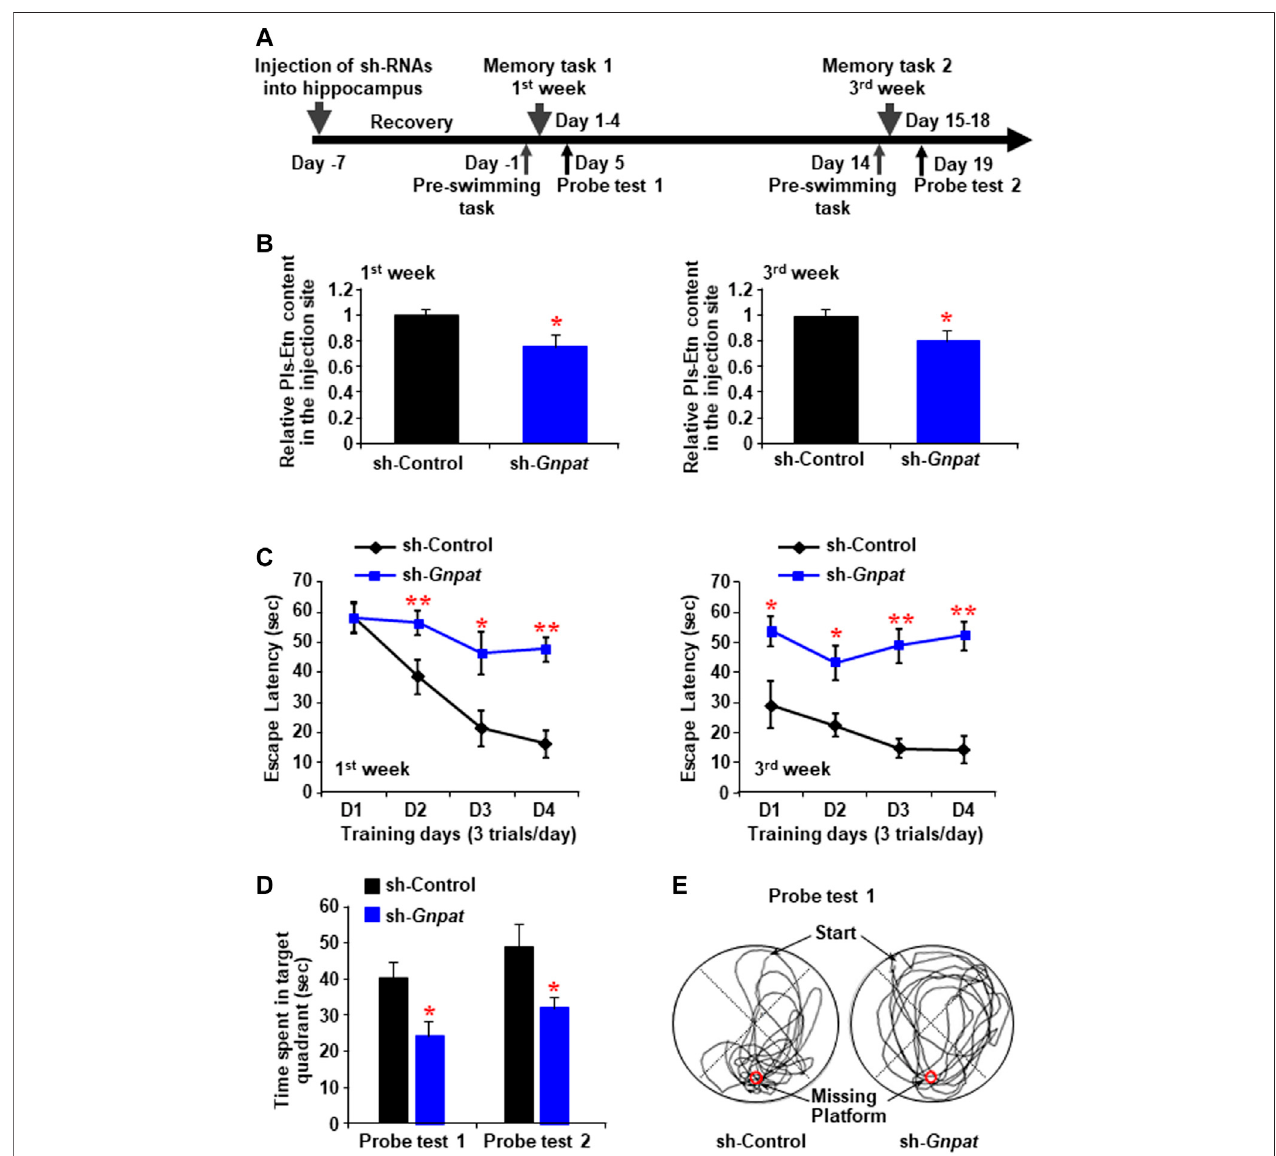
FIGURE 1 | Memory impairmentby the reduction of plasmalogen in the hippocampus. (A) Schematic diagram shows the memory tasks and probe trials schedule after the intrahippocampal injection of sh-RNA against Gnpat . (B) Mass spectroscopic data show the relative amount of ethanolamine Pls (Pls-Etn) in the hippocampus infected with lentiviruses (5 × 10 5 TDU). (C) Morris water maze task shows in the change in escape latency at the fi rst week (left panel) and third week (right panel). Data are the mean ± S.E.M. of three independent experiments. Each experiment included more than fi ve mice whose hippocampus was successfully infected by sh- GNPAT . (D) Probe tests showed the time spent in the target quadrant. (E) Examples of traces for control (left) and sh- GNPAT (right) mice in probe test one performed aftermemorytask1.Theredcircleshowstheplaceofthemissingplatform.*, p < 0.05and**, p < 0.01,ineachexperimentalgroupcomparedwiththerespectivecontrol group were analyzed by ANOVA test followed by post hoc Bonferroni ’ s